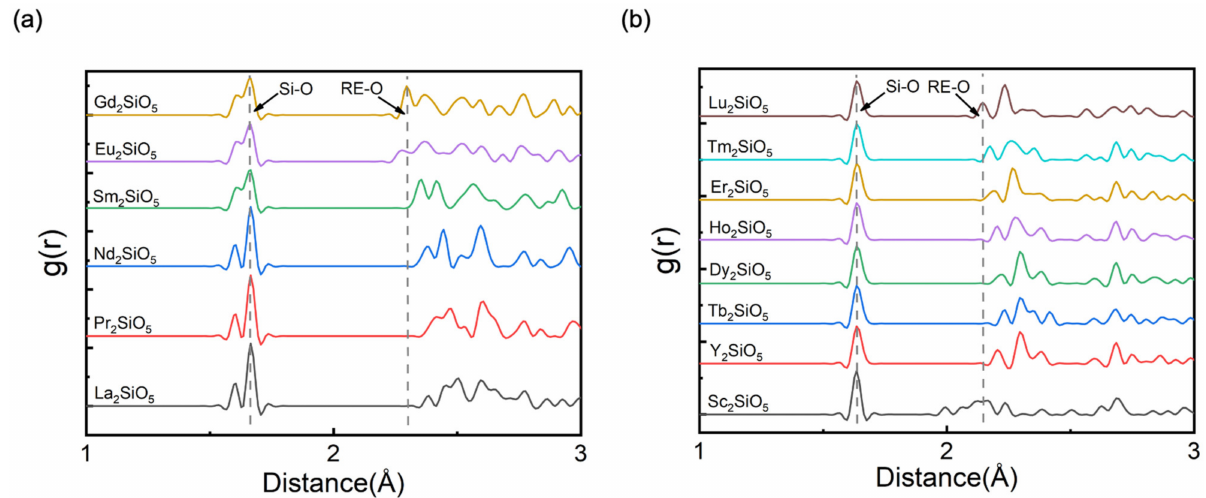
Figure 2. Radial distribution functions, g(r), of Si-O bonds and RE-O bonds in ( a ) X1-RE 2 SiO 5 and ( b ) X2-RE 2 SiO 5 compounds.